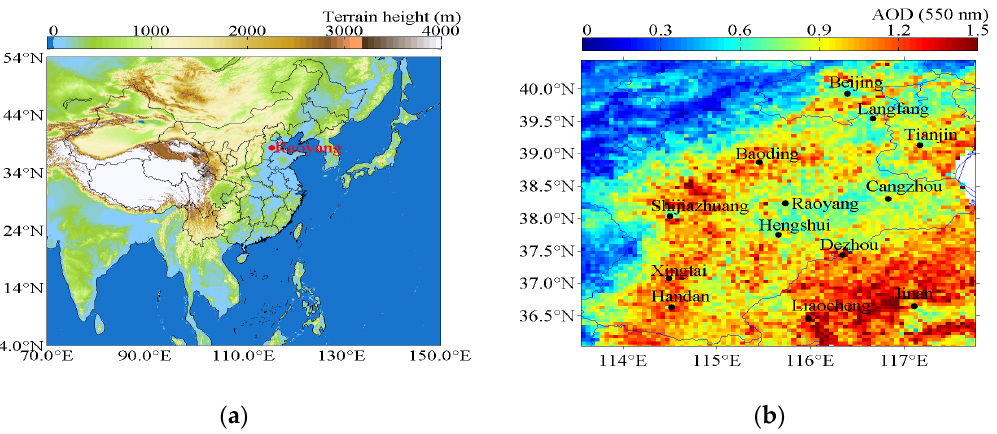
Figure 1. ( a ) Geographical location of the Raoyang Meteorological Station in the North China Plain (NCP); ( b ) average aerosol optical depths (AODs) in the summer (1 June–31 August) of 2014 extracted from the MYD04_3K product (Level 2, spatial resolution: 3 km, temporal resolution: 5 min) of the Moderate Resolution Imaging Spectroradiometer (MODIS) satellite. The observatory and its major neighborhood cities are marked by black